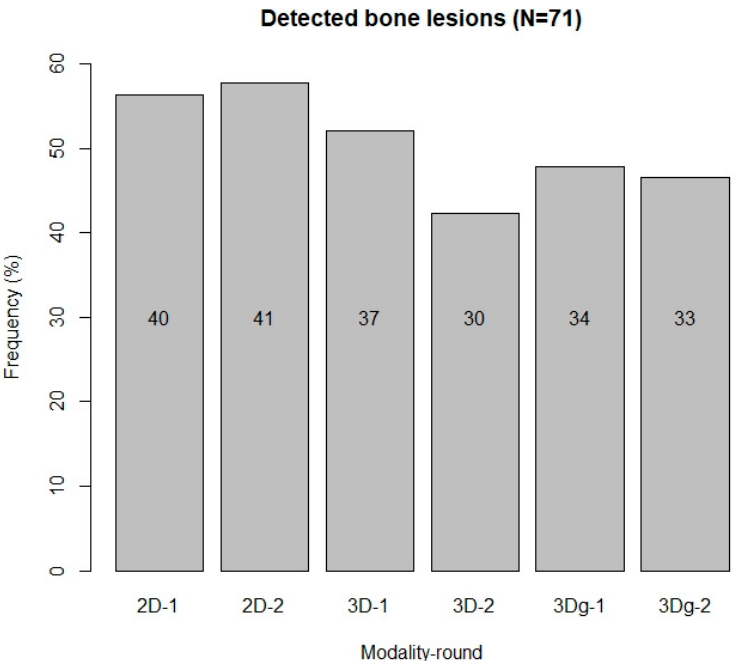
Figure 3. Number and frequency of detected bone lesions in all observations of all modalities (2D, 3D and 3Dg). 2D-1: first observation on the 2D modality; 3Dg-2: second observation on the 3D modality with anaglyph glasses.